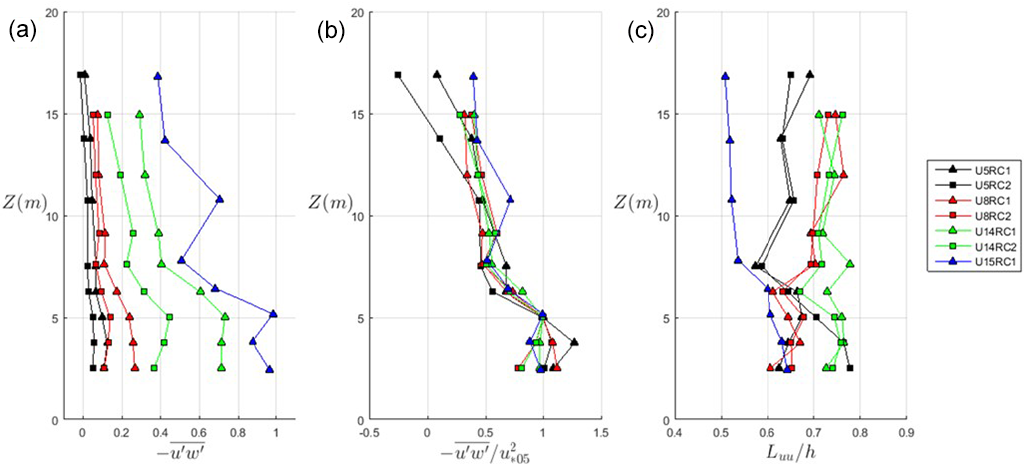
Figure 5. WindEEE inflow profiles: (a) Reynolds shear stress magnitudes, (b) Reynolds shear stress normalized by friction velocity (Method 1), and (c) integral length scales of the streamwise velocity component, normalized by hill height h .